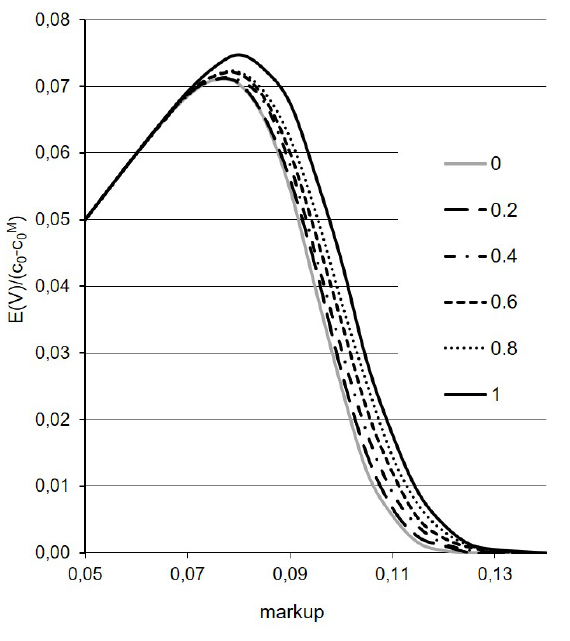
Figure 2: Simulation results: the expected profit to cost ratio E ( V ) against bid markup at different levels of correlation between the competitor’s bids (Pearson correlation coeflcient 0, 0.2, 0.4, 0.6, 0.8, 1.0)